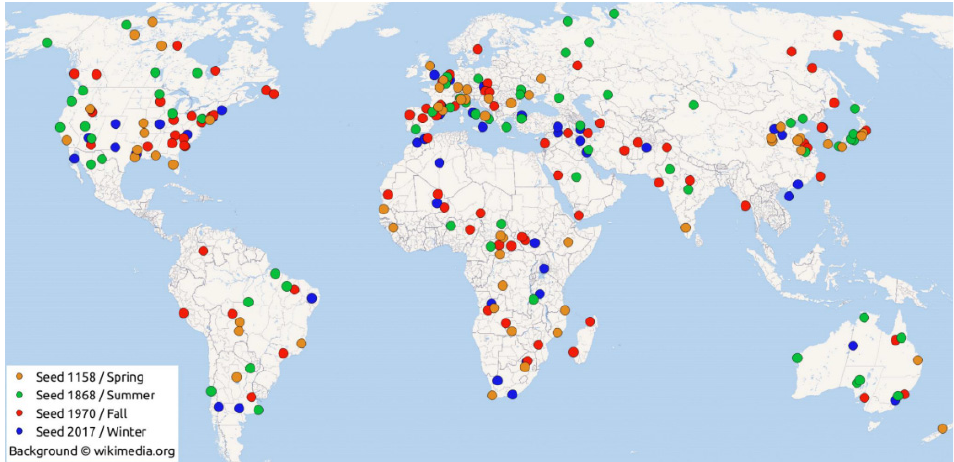
Figure 1. Distribution of regions of interest corresponding to four random seeds.